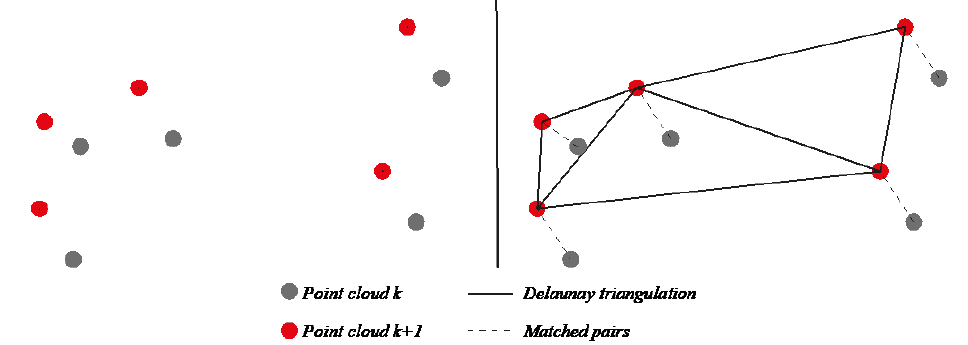
Figure 3. Left side—2-point clouds before Dalaunay triangulation; right side—Dalaunay triangulation Figure 3. Left side — 2-point clouds before Dalaunay triangulation; right side — Dalaunay triangulation and nearest neighbor match (dashed and nearest neighbor match (dashed lines).